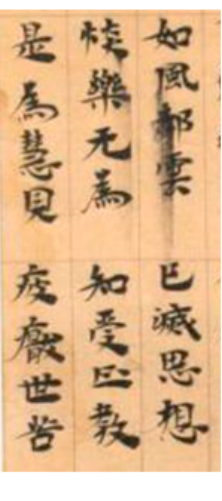
Figure 2. The Dhammapada. Figure 2. The